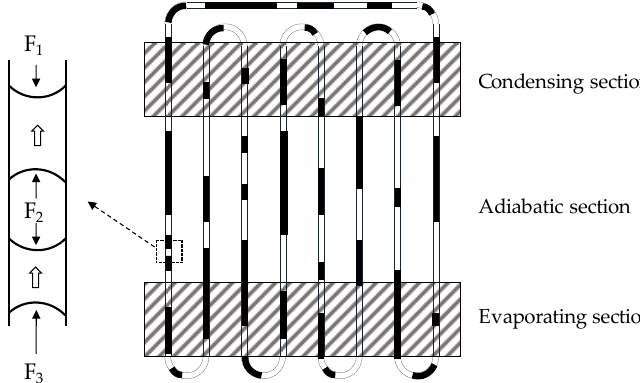
Figure 1. Schematic of a conventional pulsating heat pipe (PHP).